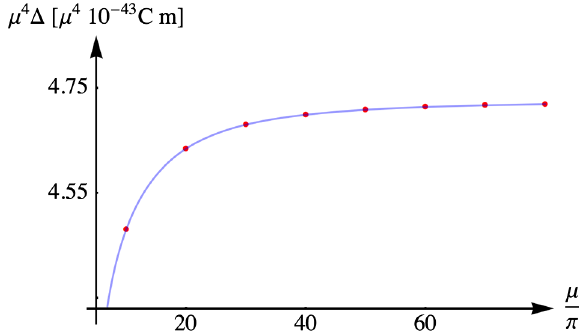
FIG. 3. Plot as a function of (cid:1) of the scaled difference (cid:3) ¼ (cid:2) P o Þ ; here, P o (cid:1) 4 ð P o is defined by Eq. (3.47), and the (cid:3) (cid:3)num (cid:3) difference is taken between the result from the asymptotic expansion based on Eq. (3.43) and the result from a numerical . The scaled difference approaches a constant calculation P o (cid:3)num as (cid:1) ! 1 and thus confirms the error